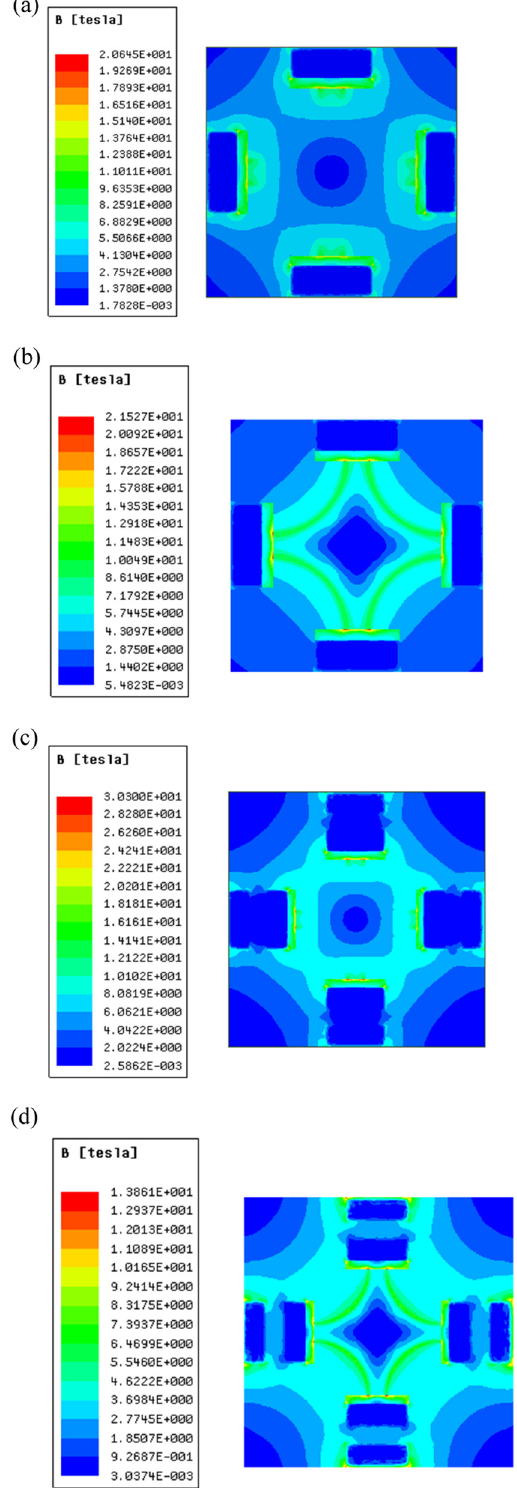
Figure 14: Magnetic fi eld distribution of armature. ( a ) Front end of standard armature, ( b ) rear end of standard armature, ( c ) front end of proposed armature, and ( d ) rear end of proposed armature.